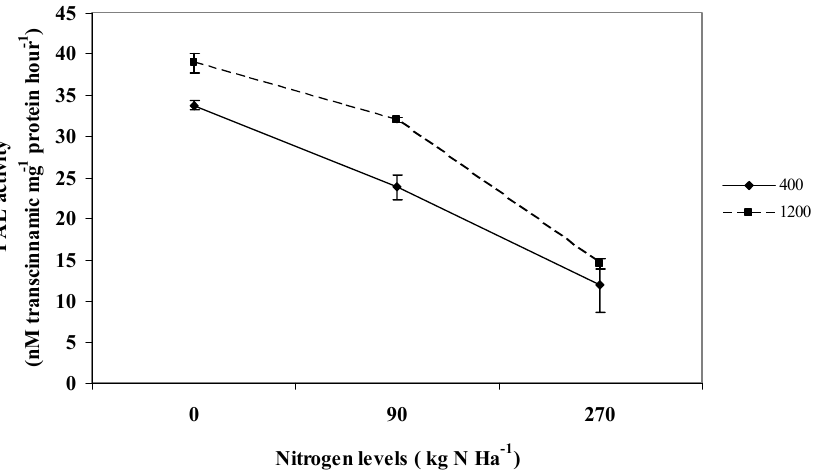
Figure 4. Interaction effects between CO L. pumila . N = 12. Bars represent standard error of differences between means